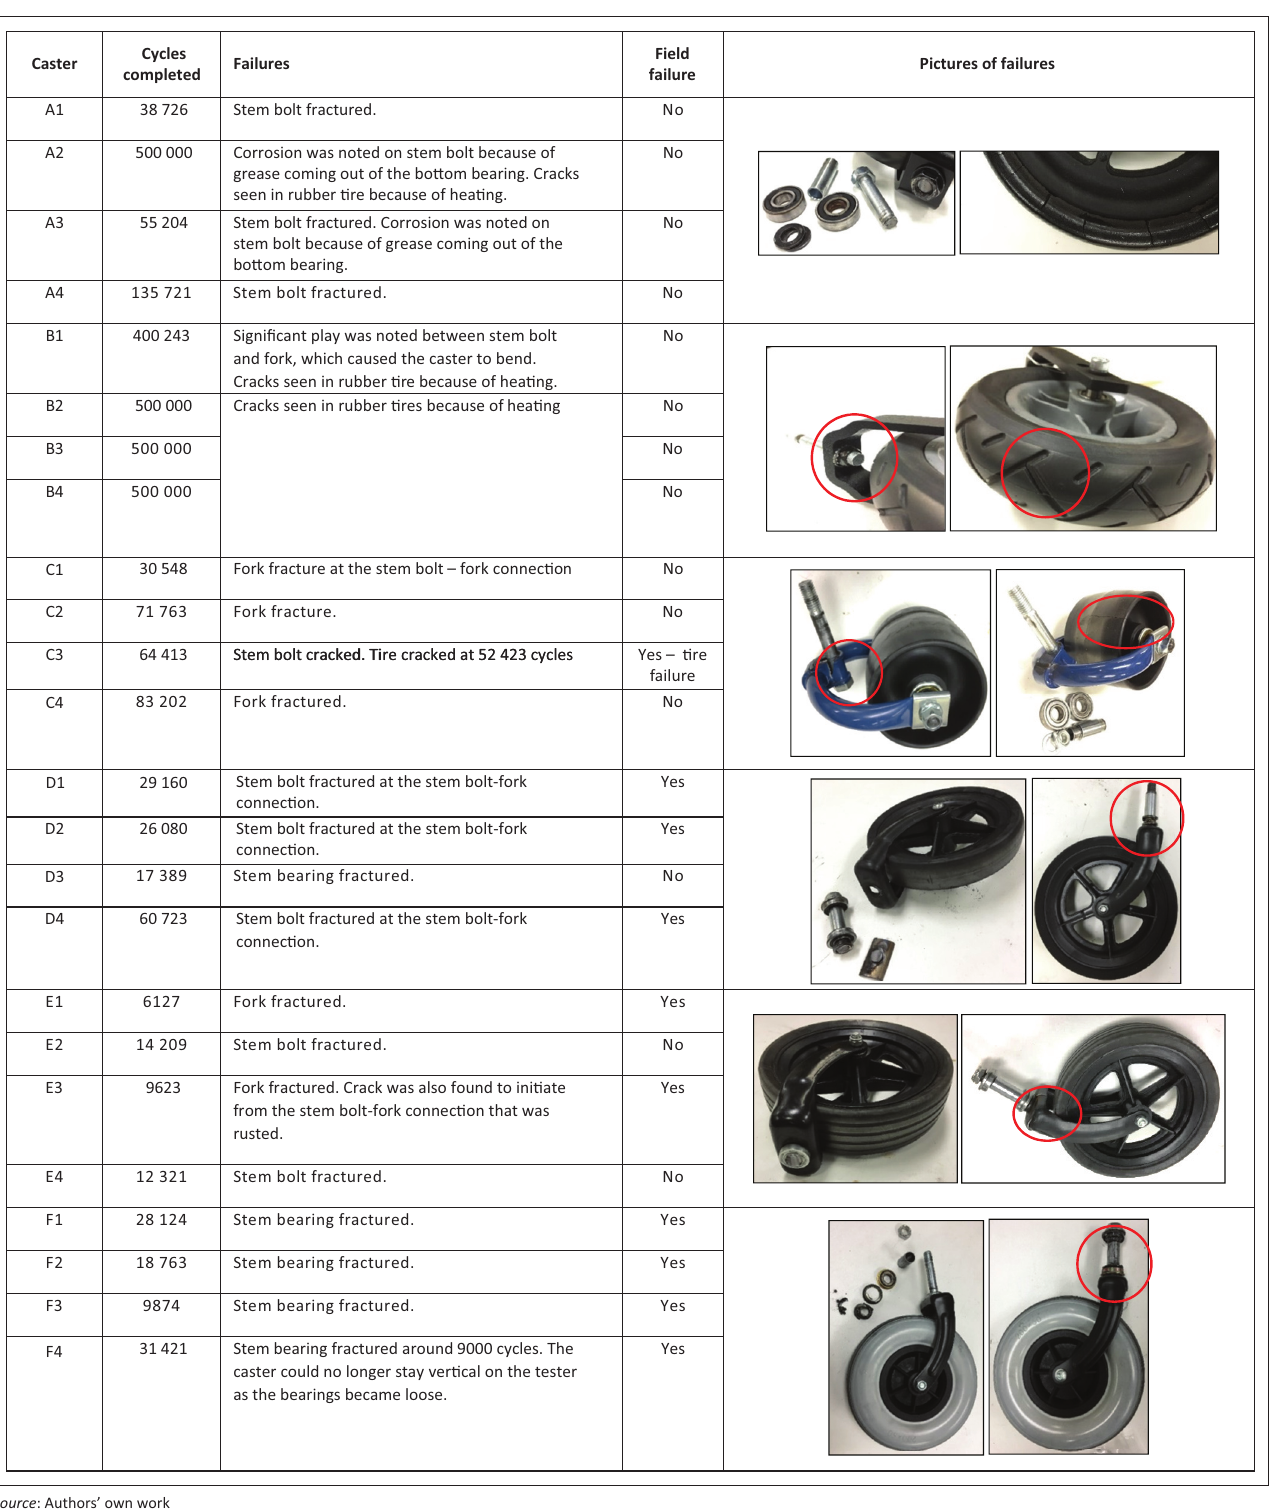
FIGURE 16: Preliminary testing results with different caster